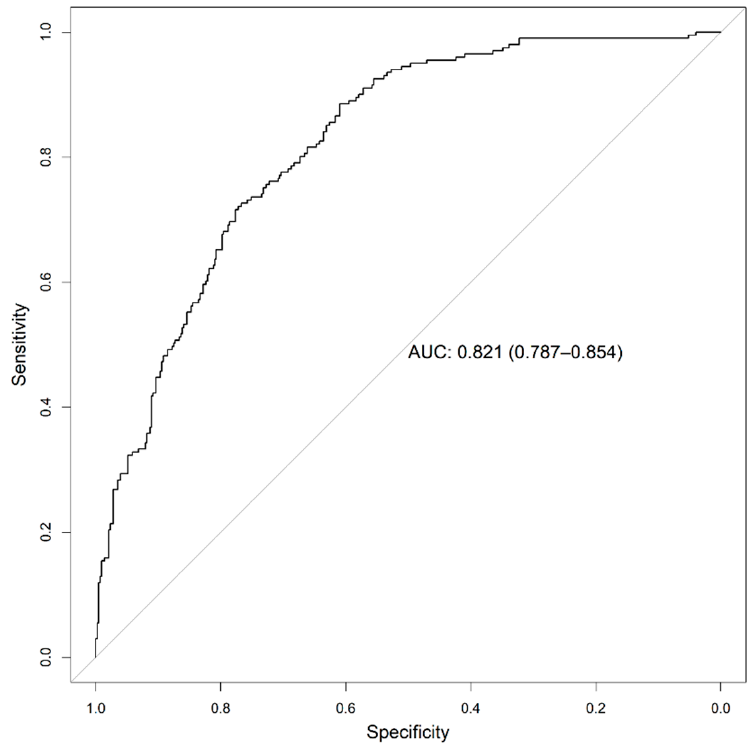
Figure 8. Calibration curve for the external validation dataset.